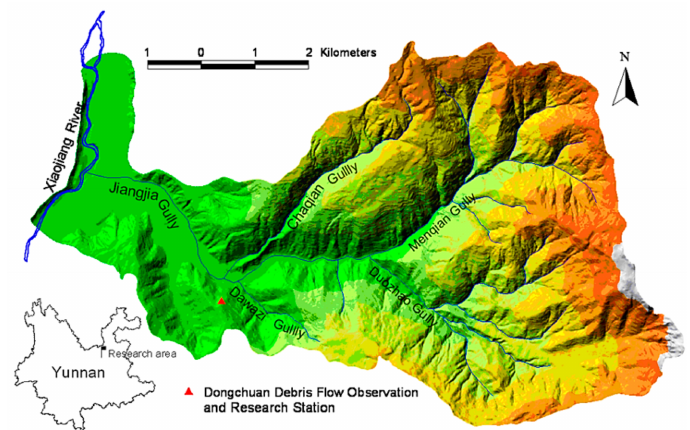
Figure 2. Location of Jiangjia Gully Basin. The triangle represents the Dongchuan Debris Flow Observation and Research Station (DDFORS) (© [43]).